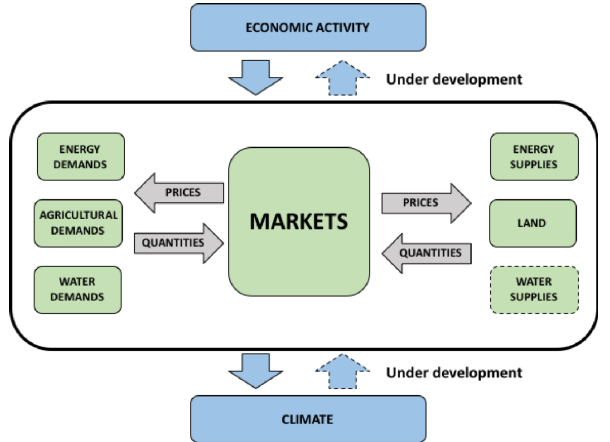
Figure 3. Conceptual schematic of the operation of the GCAM